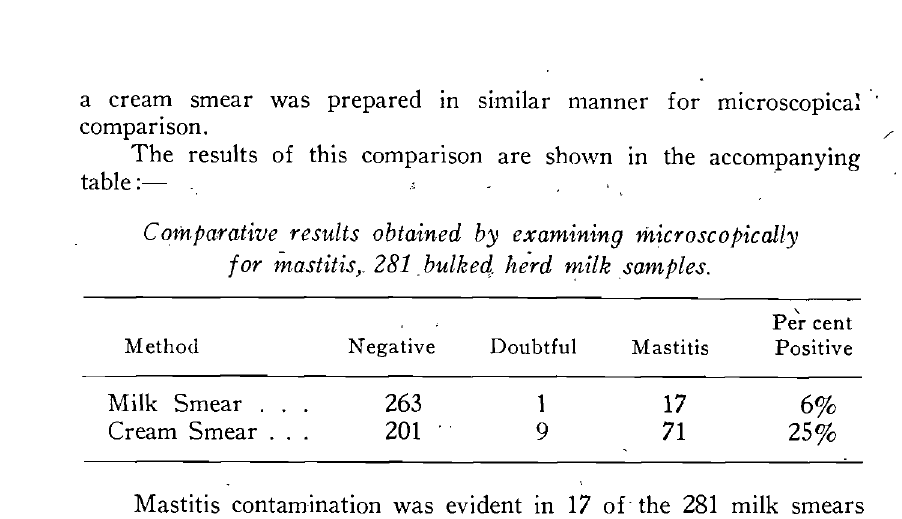
C ofnparative results obtained by examining microscopically for 11tastitis, 281.bulkeq. herd milk